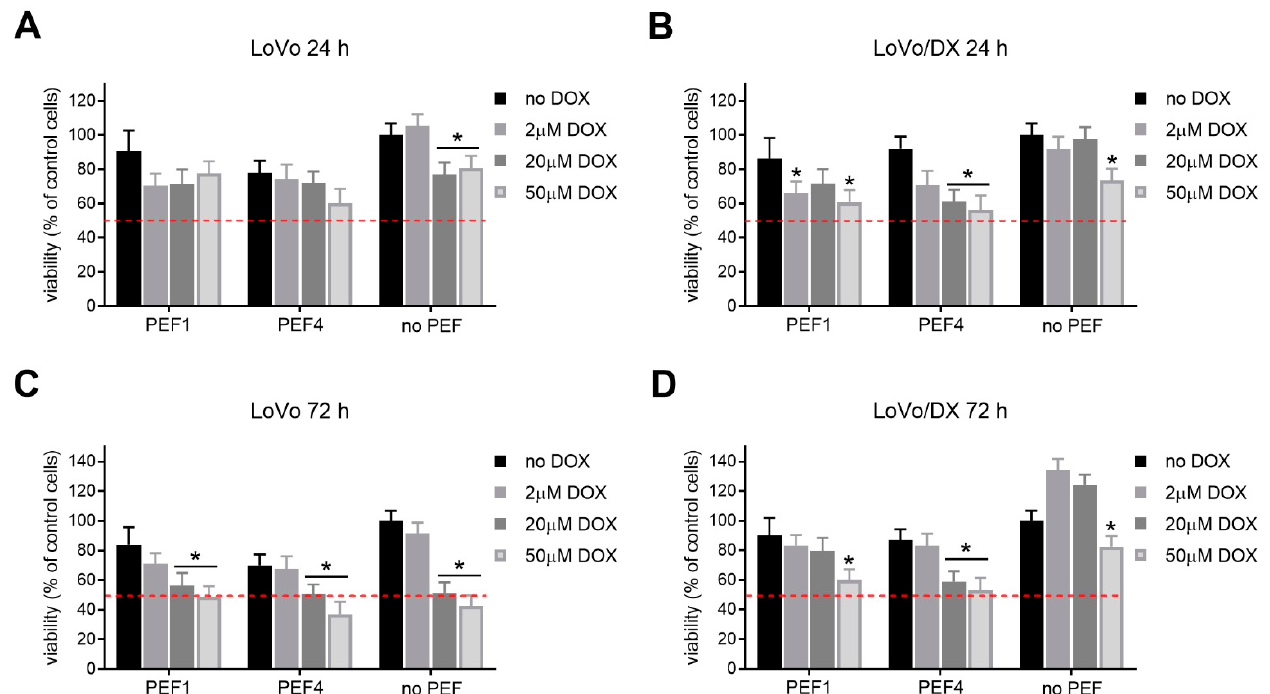
Figure 6. The viability of cells exposed to electrical pulses without (no DOX) and with doxorubicin (DOX, C DOX = 2, 20 or 50 µ M) after 24 h for LoVo ( A ) and LoVoDX ( B ) cells; 72 h for LoVo ( C ) and LoVoDX ( D ) cells. The following treatment protocols were used: PEF1—10 kV/cm × 300 ns × 200; PEF4—1.2 kV/cm × 100 µ s × 8 (ESOPE). All the data are normalized to untreated control. Asterisk (*) corresponds to statistically significant ( p < 0.05) difference.